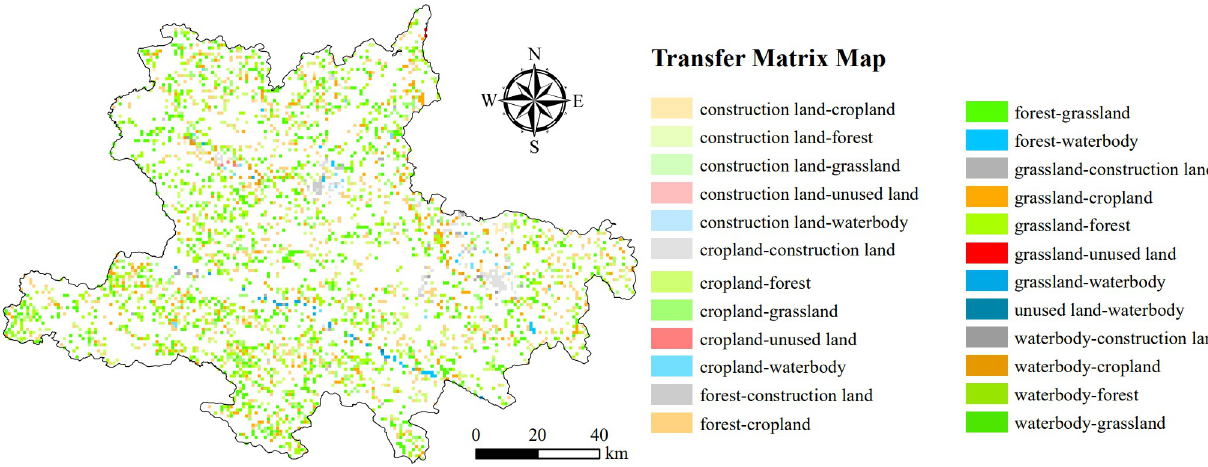
Fig 2. Change of land use type in Hani area from 1995 to